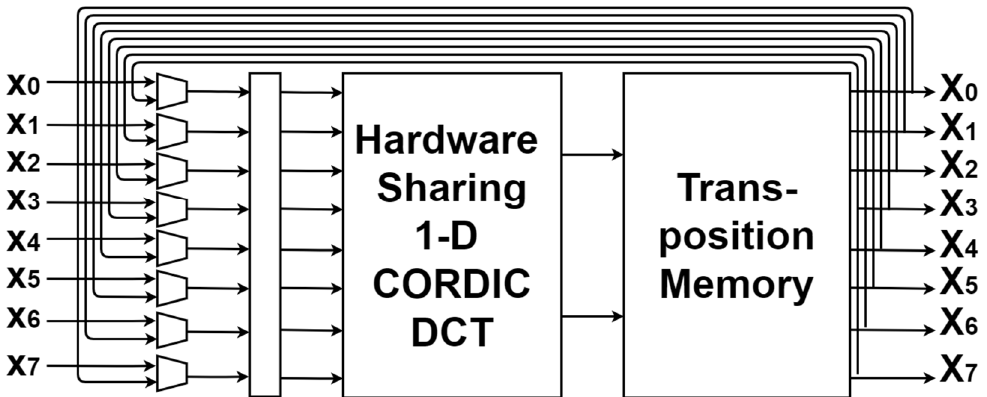
Figure 5. The architecture of a 2-D DCT is realized by a hardware-sharing machine 1-D DCT.